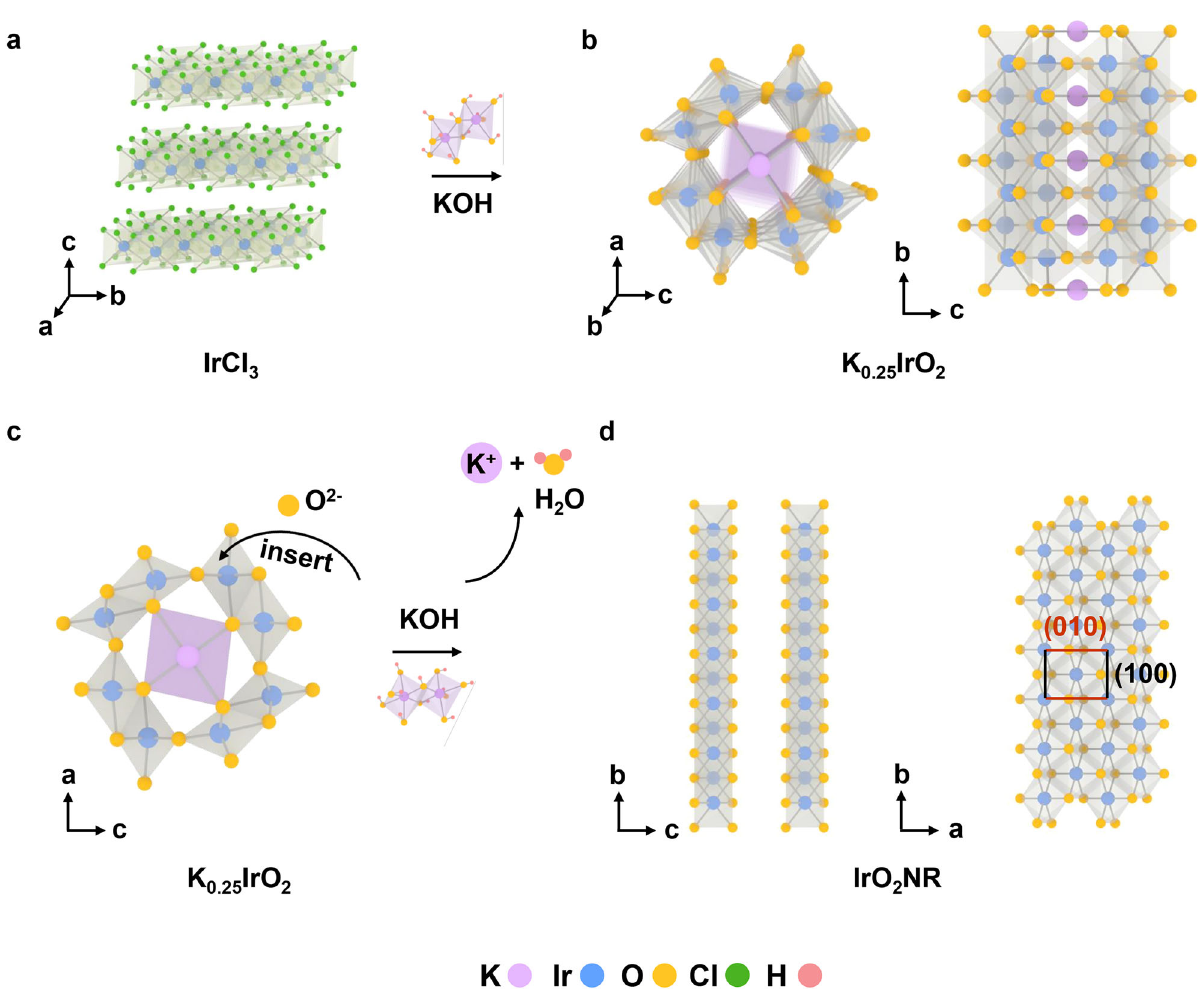
Fig.2|StructuralevolutionoftheIrO 2 NR.a , b FromtherawmaterialsofIrCl 3 andKOHtoK 0.25 IrO 2 . c , d FromK 0.25 IrO 2 totheIrO 2 NR.Purple,blue,yellow,greenandpink balls represent K, Ir, O, Cl and H elements,